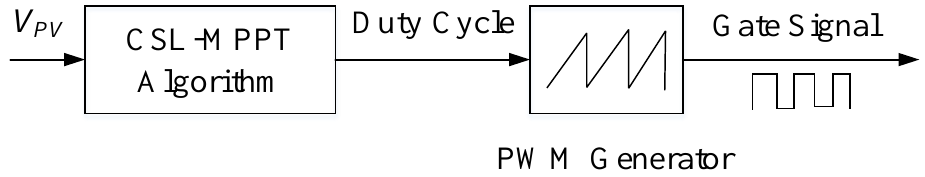
Figure 6. The control diagram of the proposed CSL-MPPT control.